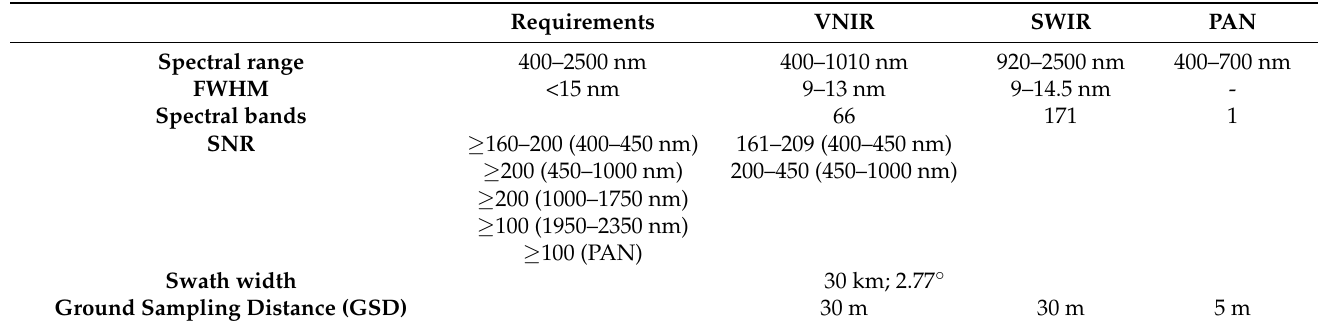
Table 1. Main characteristics of PRISMA. The first column reports the MRD requirements, while the last three columns show the sensors’ performance levels, as derived by